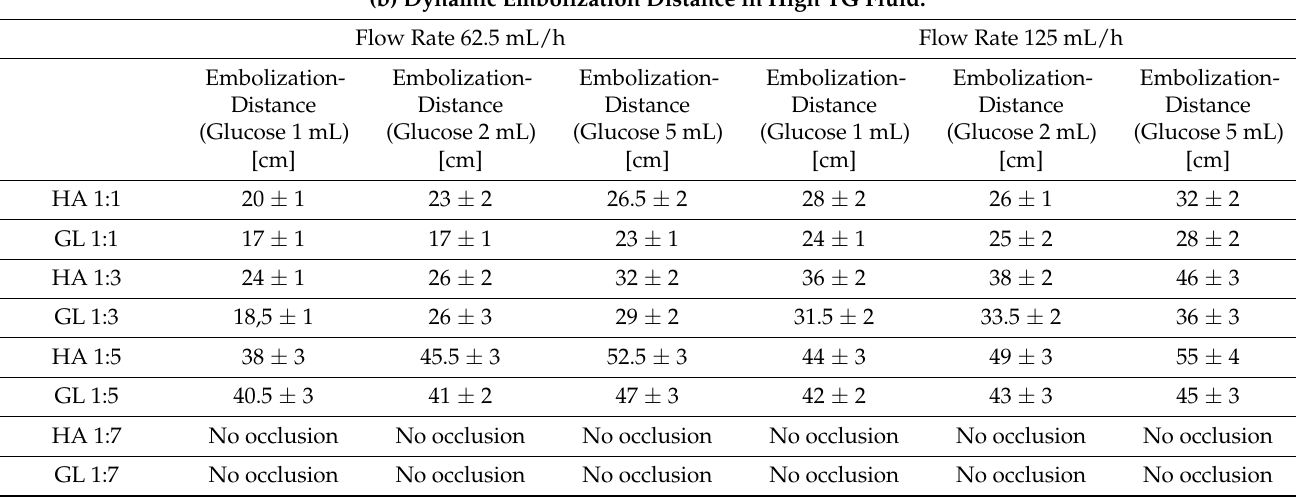
Table 2. Cont. (b) Dynamic Embolization Distance in High TG